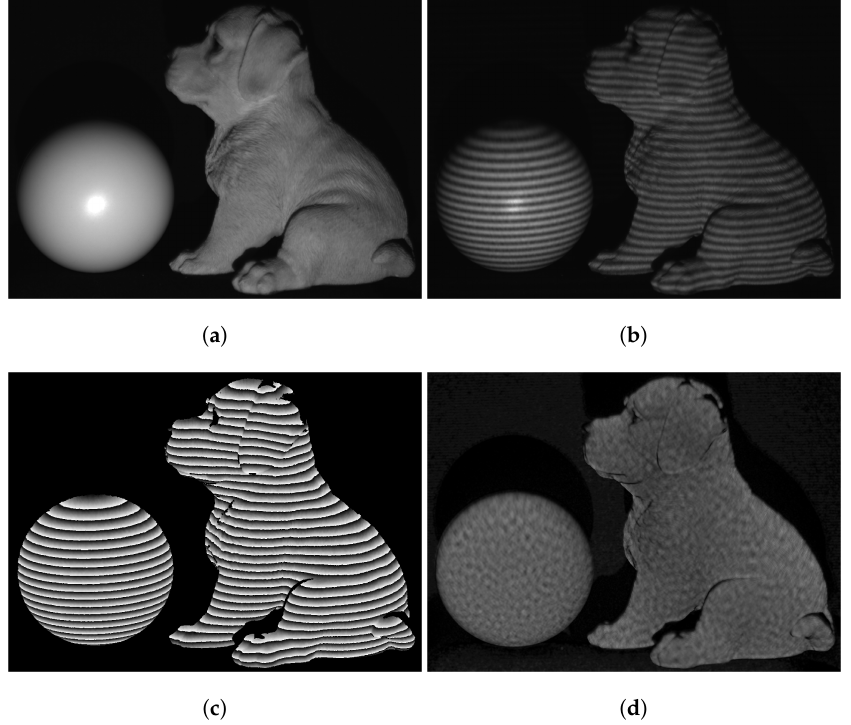
Figure 6. Measurement of two isolated 3D objects. ( a ) Photograph of the objects. ( b ) One of the fringe images. ( c ) Wrapped phase φ . ( d ) Recovered speckle image ˆ I o